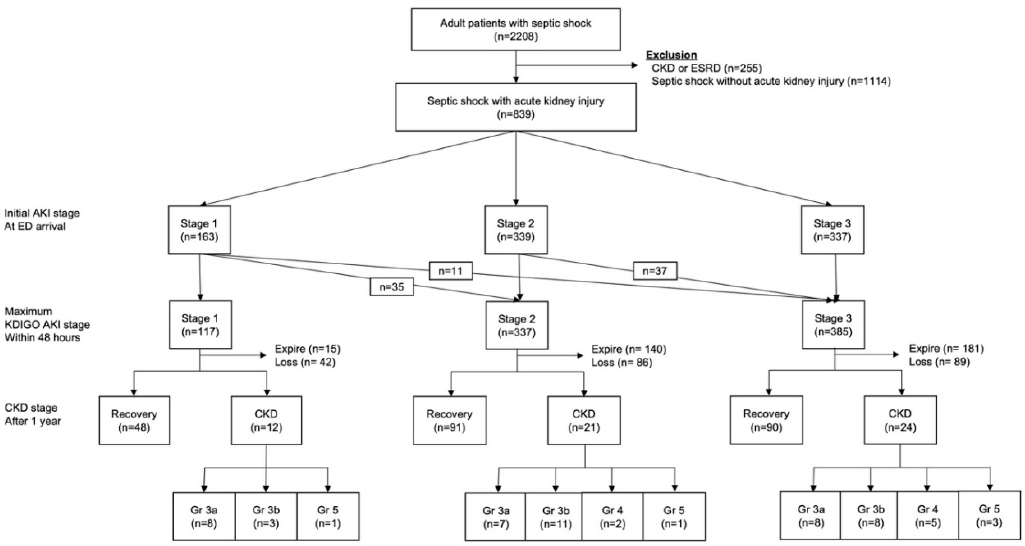
Figure 1. Flowchart of the study population. 119